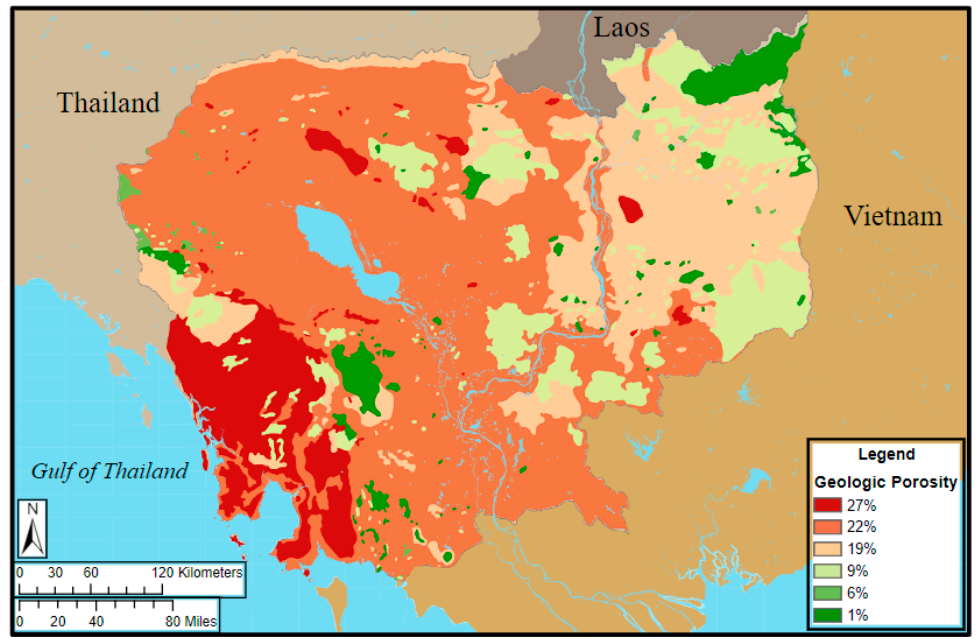
Figure 2. Geologic porosity map of Cambodia. Adapted from Gleeson’s et al. [31] GLMYPHS database.